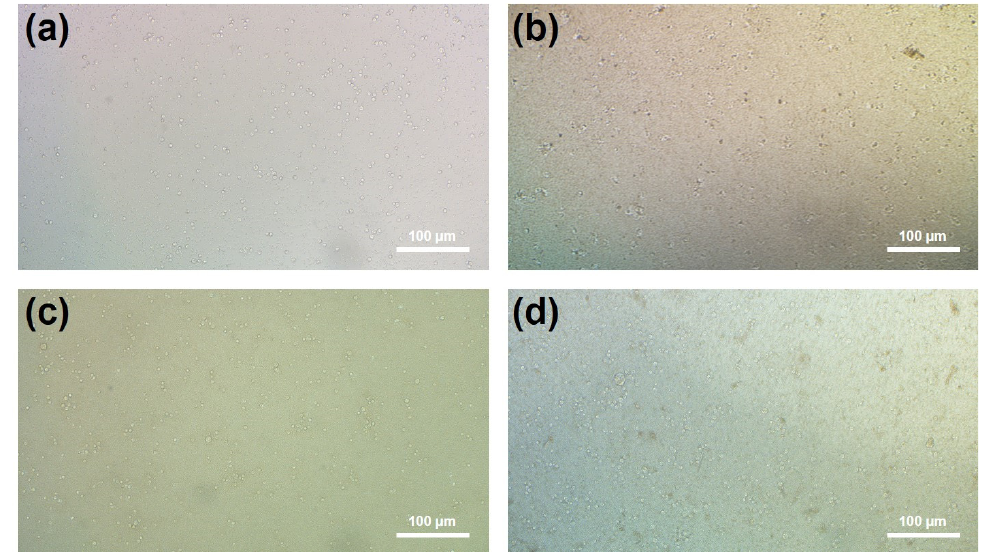
Figure 10. Morphologies of MC3T3-E1 osteoblast cells cultured on ( a ) bare Mg, ( b ) EPD-GO-A-, ( c ) EPD-GO-E-, and ( d ) EPD-GO-W-coated Mg samples after 3 days of incubation.